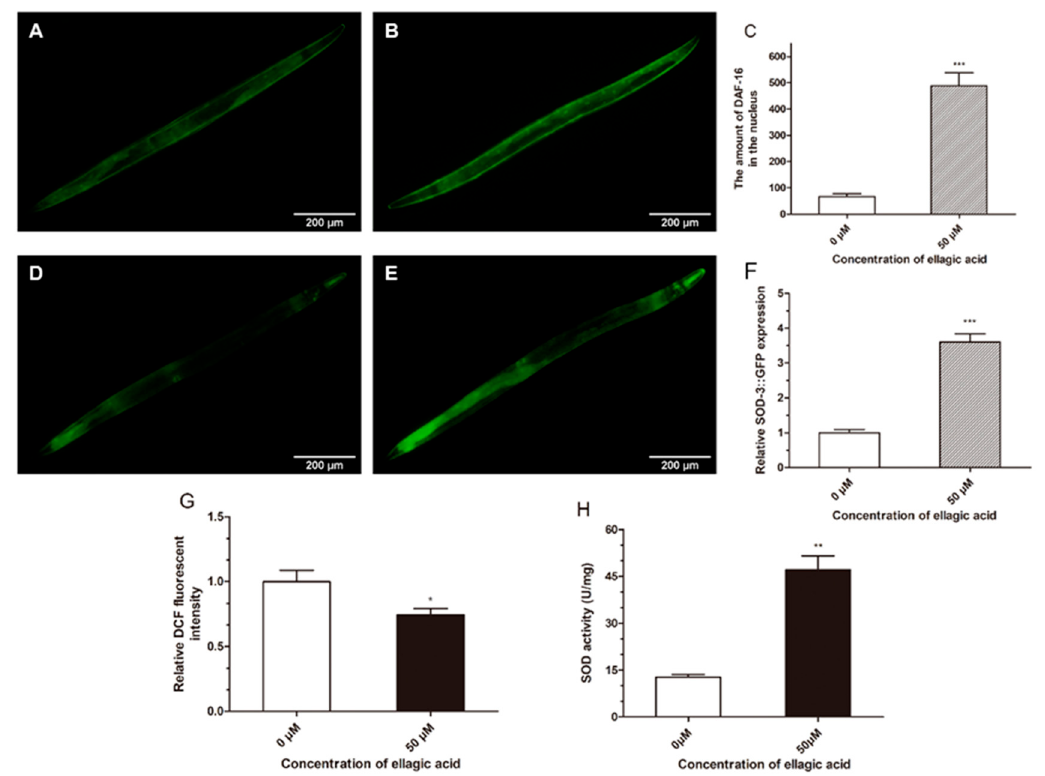
(Figure 4B). Taken together, ellagic acid resists the UV radiation stress in nematodes via the insulin/IGF-1 signaling pathway-dependent manner.